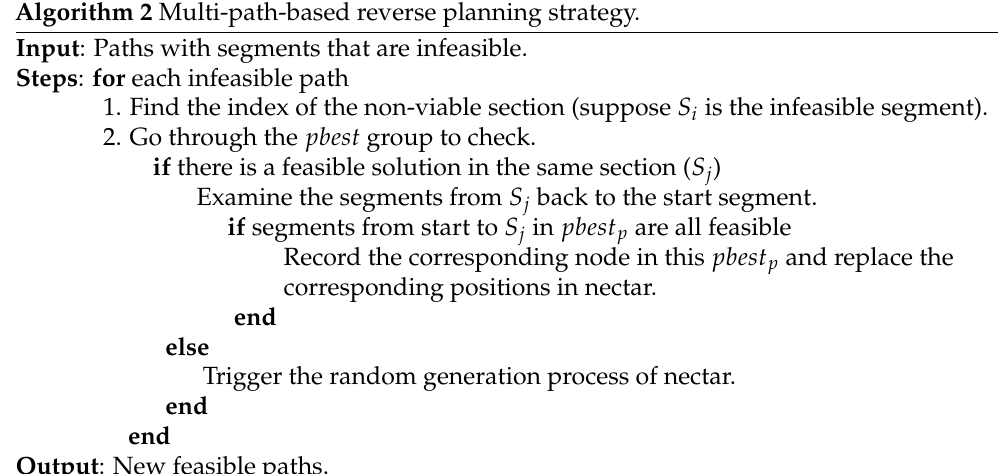
Algorithm 2 Multi-path-based reverse planning